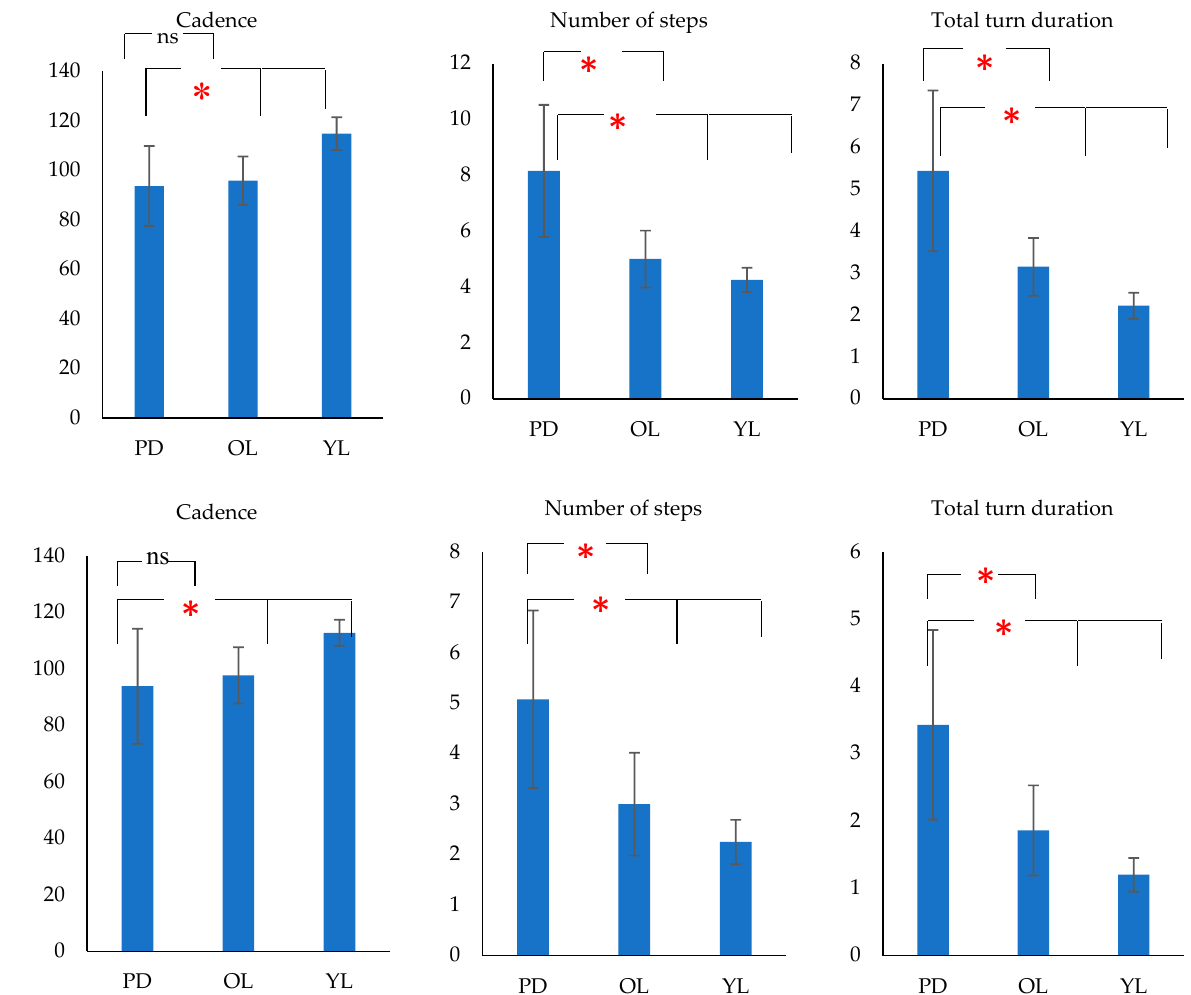
Figure 6. Bar charts showing mean cadence, number of steps and total turn duration for PD, OL and YL subjects for ( a ) U ‐ turn and ( b ) Turn around a point (* p (Significance) < 0.05, ns (non ‐ significant)).